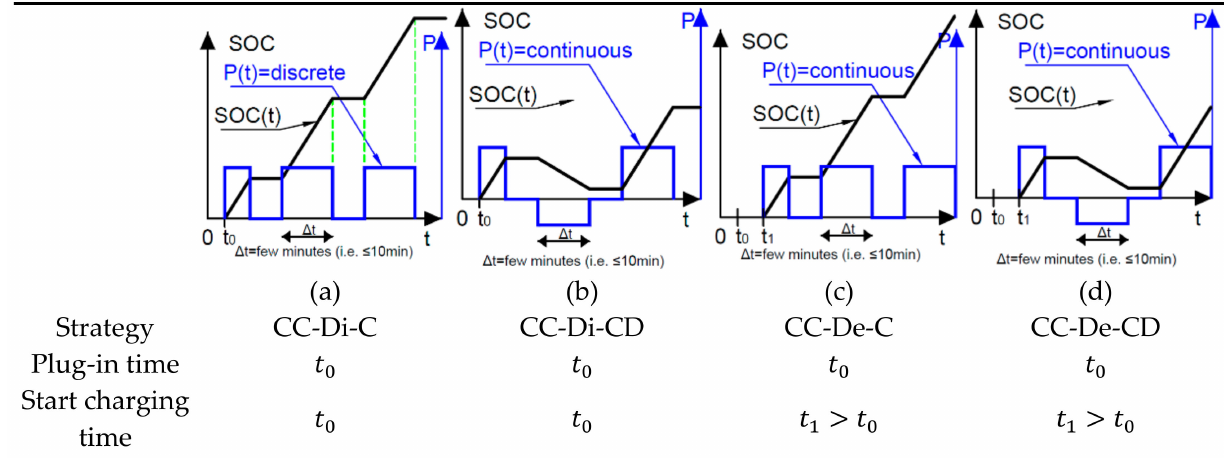
Figure 4. Illustration SOC and Discharge Power for Discrete Coordinated